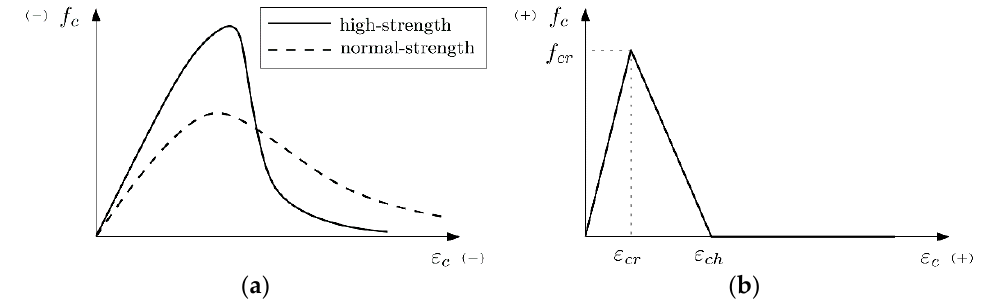
Figure 5. ( a ) Scheme of the pre-peak compression model and ( b ) scheme of the linear tension softening model.